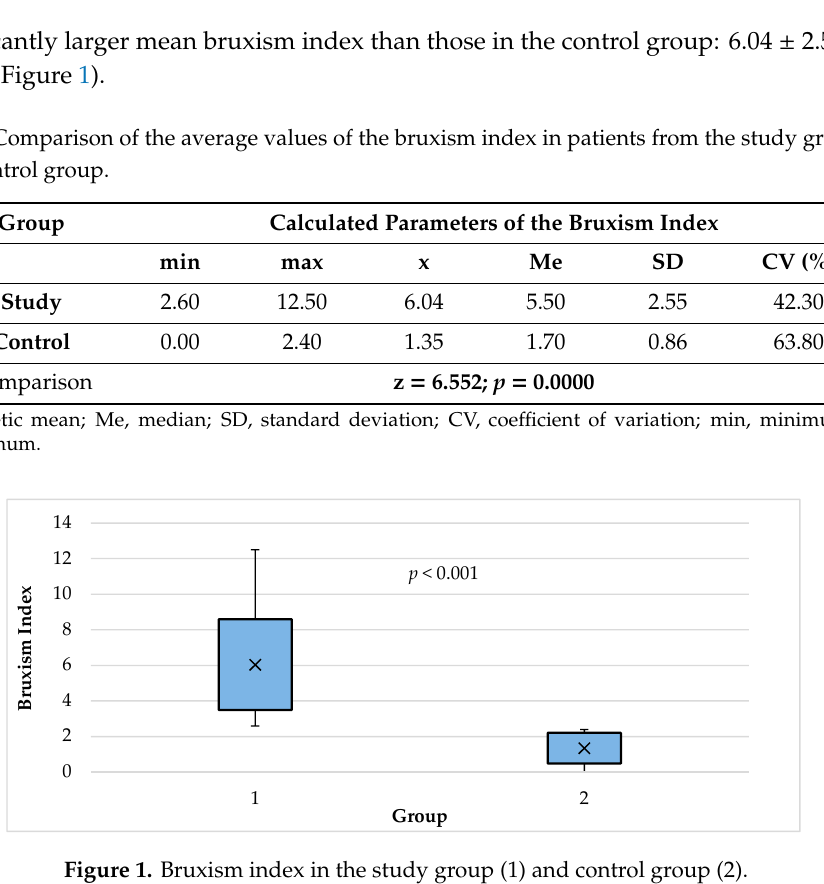
Figure 1. Bruxism index in the study group (1) and control group (2).